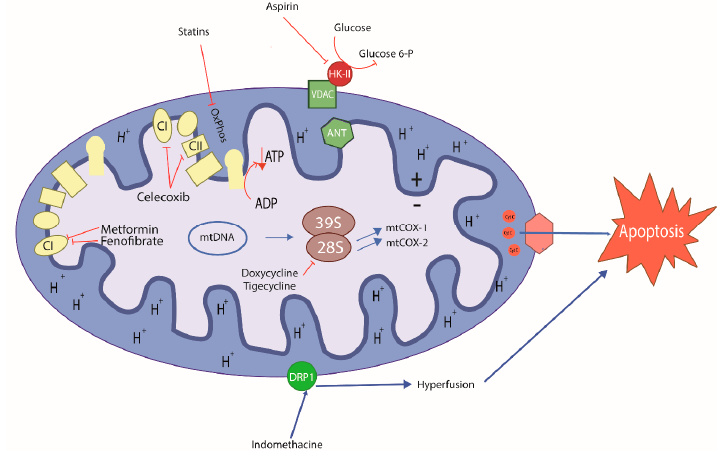
Figure 3. Schematic mode of action of old repurposing drugs in cancer cell. Antibiotics, anti ‐ inflammatories, and metabolic control drugs can target mitochondria inducing metabolic stress, leading to cancer cell and CSC death. Doxycycline and tigecycline are antibiotics; acetylsalicylic acid, celecoxib and indomethacin are anti ‐ inflammatories; fenofibrate, simvastatin and lovastatin are antilipemic; metformin is antiglycemic. (+) Positive charge in mitochondrial intermembrane space; ( − ) negative charge on the matrix side of the inner mitochondrial membrane; blue lines: induced effects; inhibitory red lines: inhibitory effects of repurposing drugs; CI: Mitochondrial Complex I; CII: Mitochondrial Complex II.